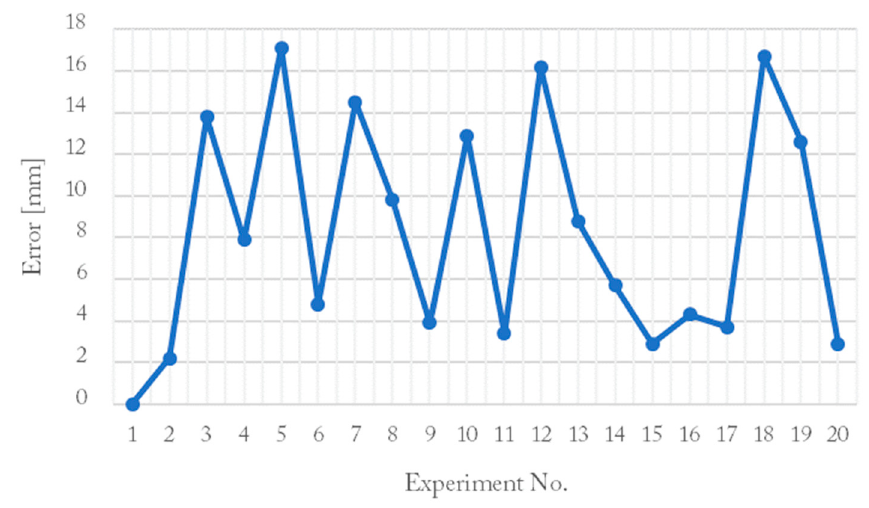
Figure 21. Field experiment results of sweet pepper’s position extraction algorithm (vertical axis).